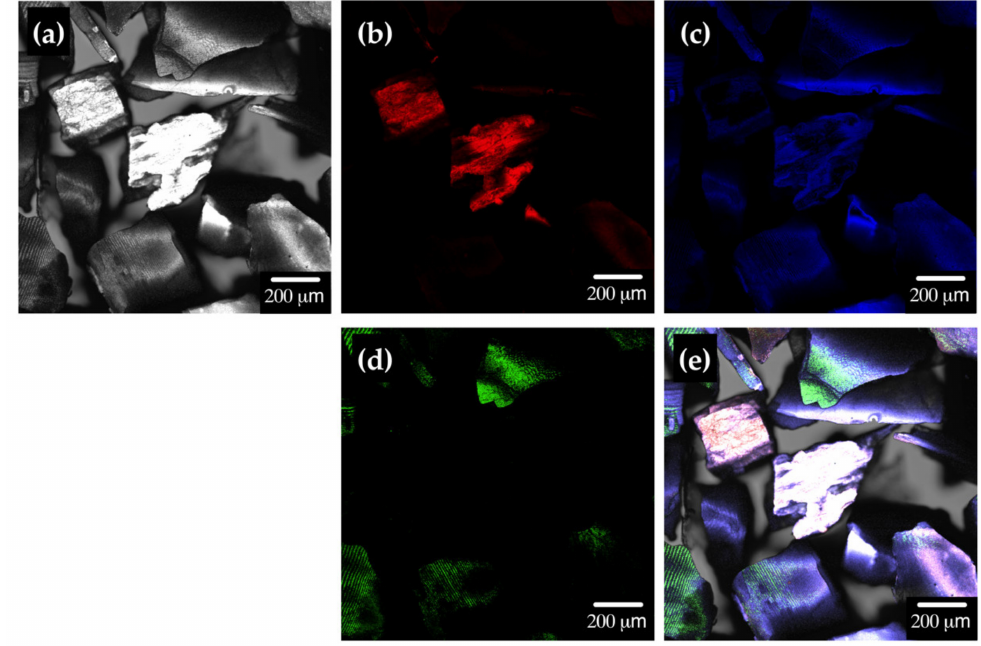
Figure 8. ( a ) Optical and ( b – d ) confocal micrographs of the Zn 2+ -loaded CS at ( b ) 519 nm, ( c ) 461 nm, and ( d ) 636 nm. ( e ) Overlay of all four images for the Zn 2+ -loaded